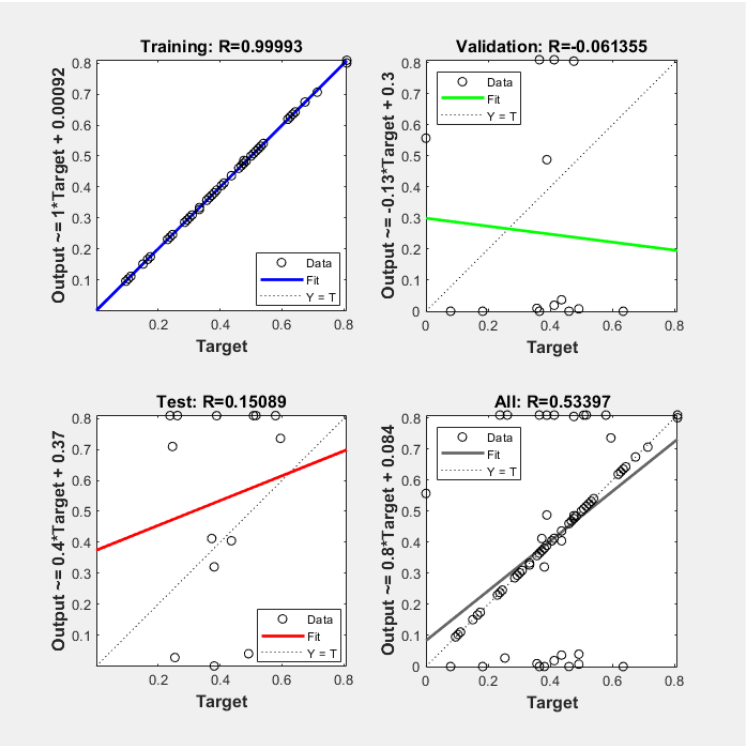
Figure 12. Overfitting problem caused by developing high abstraction model.